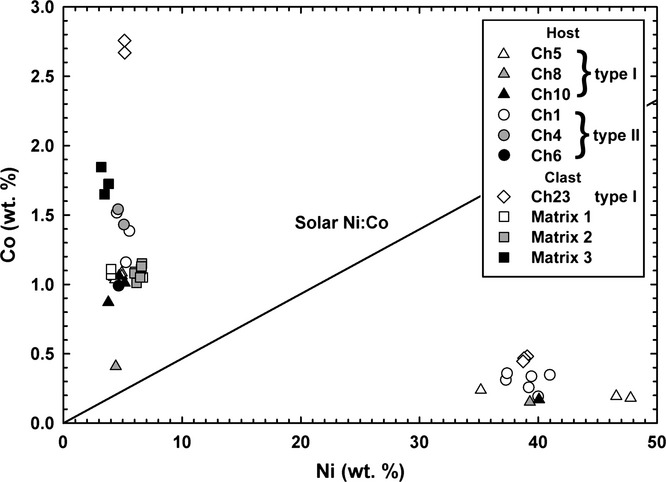
Cobalt and Ni (both wt%) content of individual metal grains in chondrules and matrix of RBT 04133,8. Nickel-rich metal is depleted in Co relative to Ni-poor metal, similar to observations of metal in thermally metamorphosed ordinary and CO chondrites (Kimura et al. 2008). The solar Ni:Co ratio line is shown for reference (data from Lodders et al. 2009).